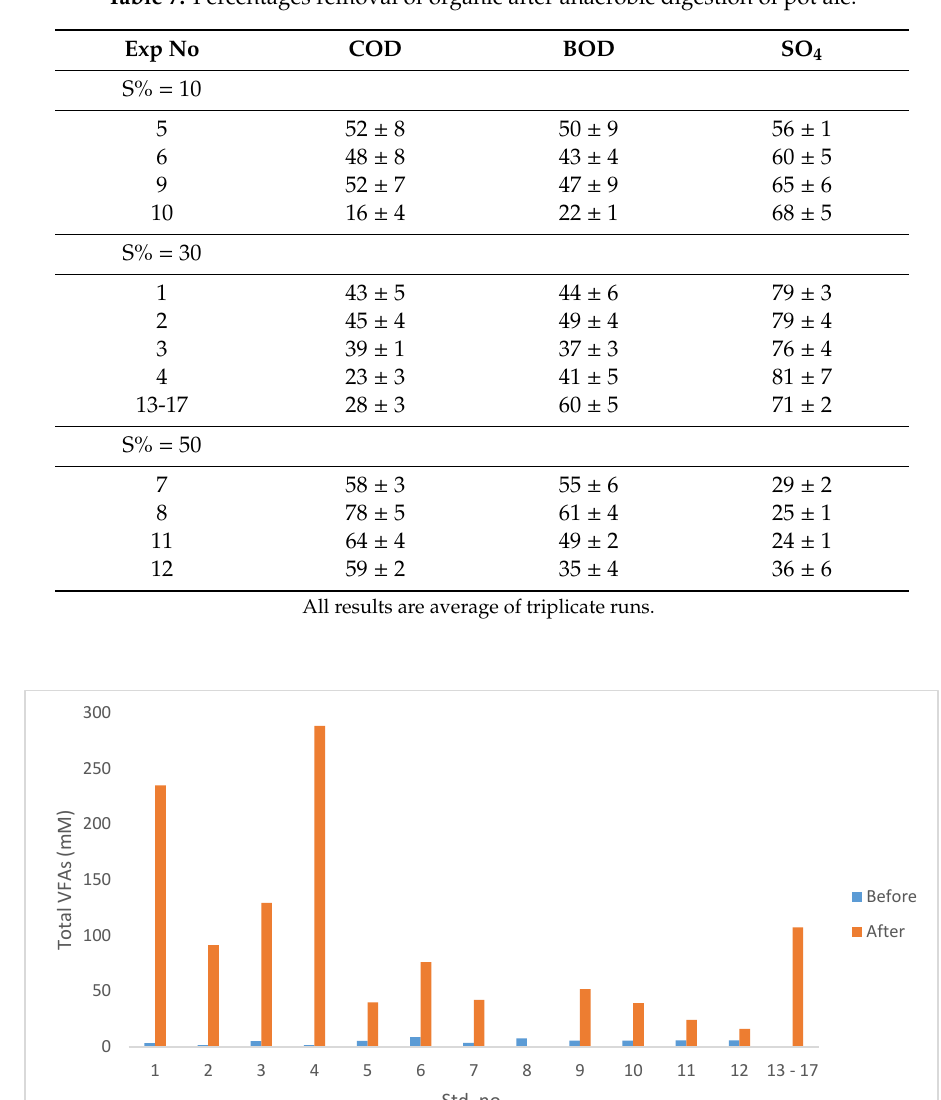
Table 7. Percentages removal of organic after anaerobic digestion of pot ale.